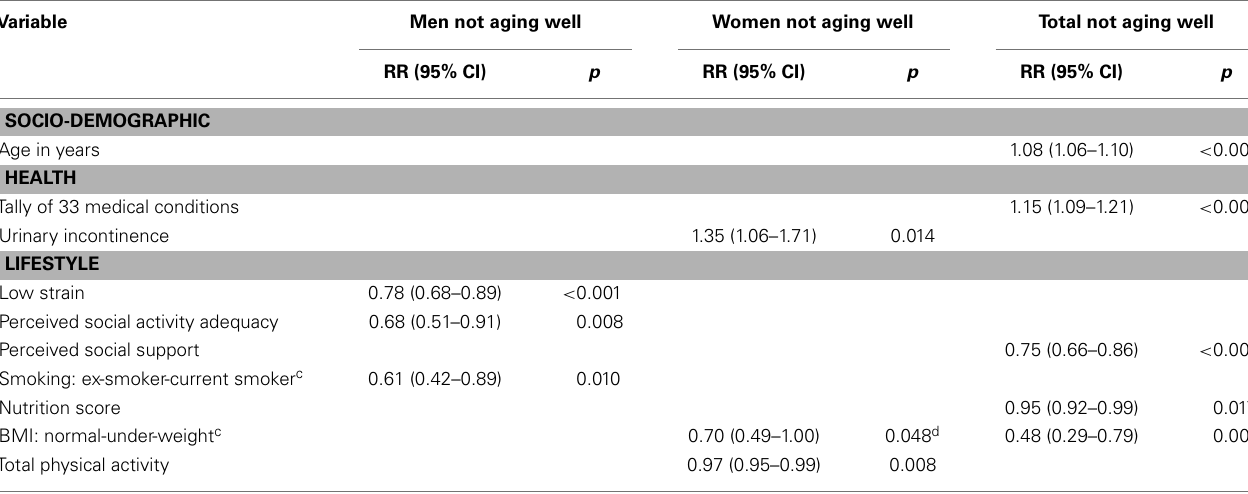
Table 3 | Final model for significant baseline threats to aging well over 12years for men and women and the total sample a,b